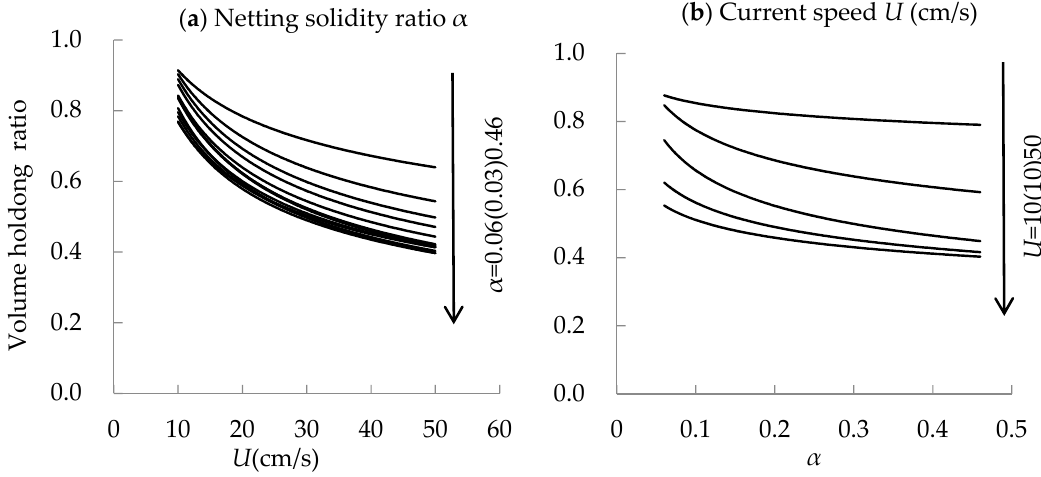
Figure 8. Relationship of volume holding ratio and mesh factor plotted against current speed. ( a ) the relationship of C v and U for each α ; ( b ) the relationship between C v and α for each U.